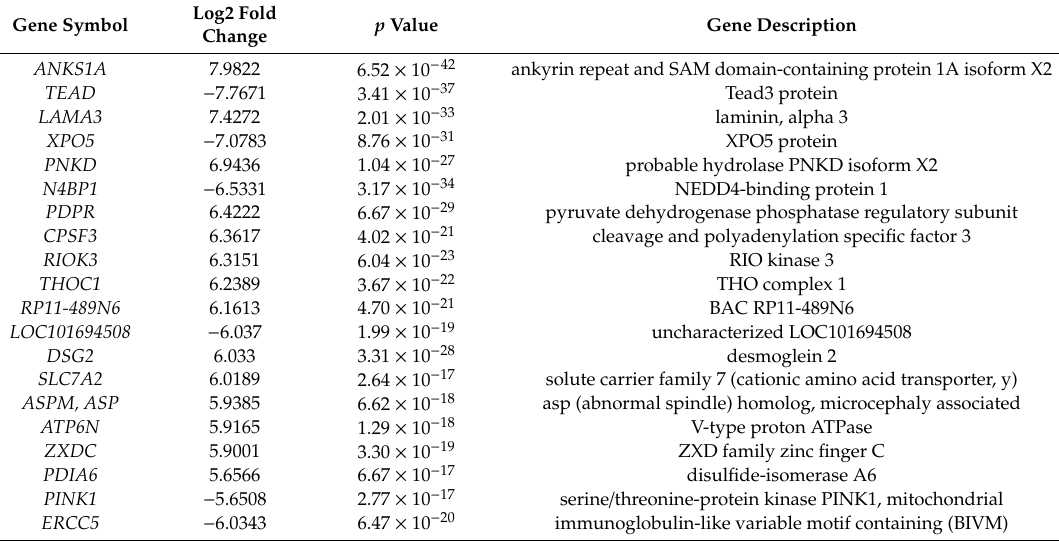
Table 2. The top 20 most DEGs in the activated uterus compared with the diapause uterus ( p < 0.05). Log2 Fold p Gene Symbol Change